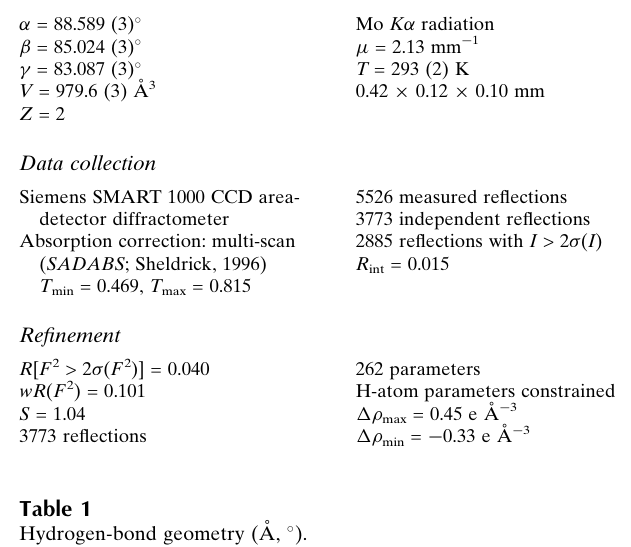
Hydrogen-bond geometry (A˚ , (cid:1)